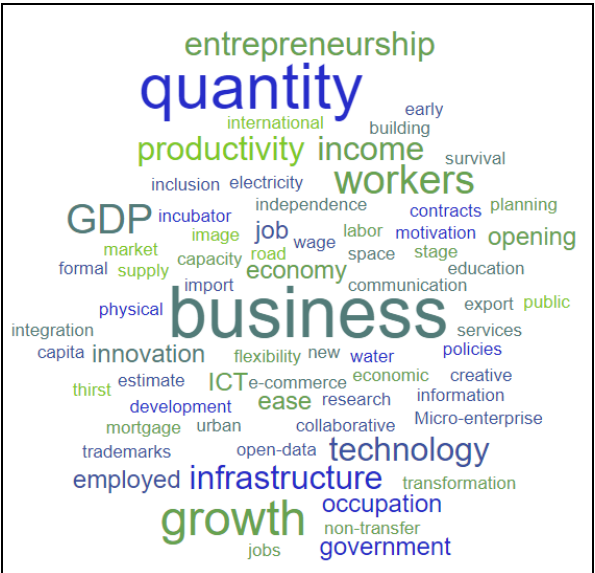
Figure 16. Most frequent indicators within the theme of “economy”.